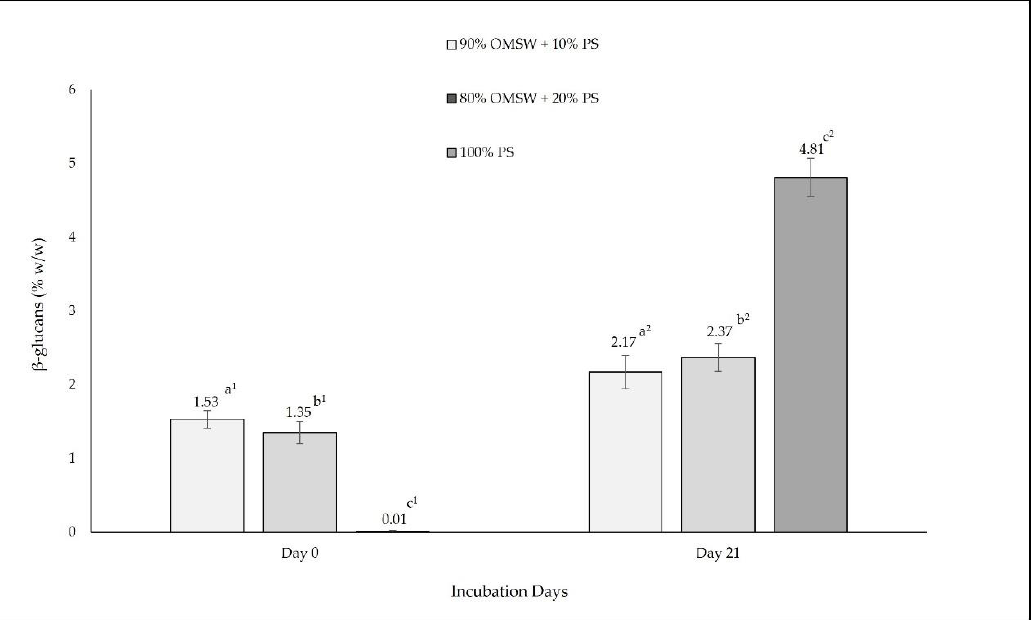
Figure 10. Evaluation of β -glucans content for PS and its mixtures with OMSW. Statistical analysis was performed for each substrate individually between Day 0 and Day 21. Different superscripts between the same letters indicate statistical significance ( p ≤ 0.05).